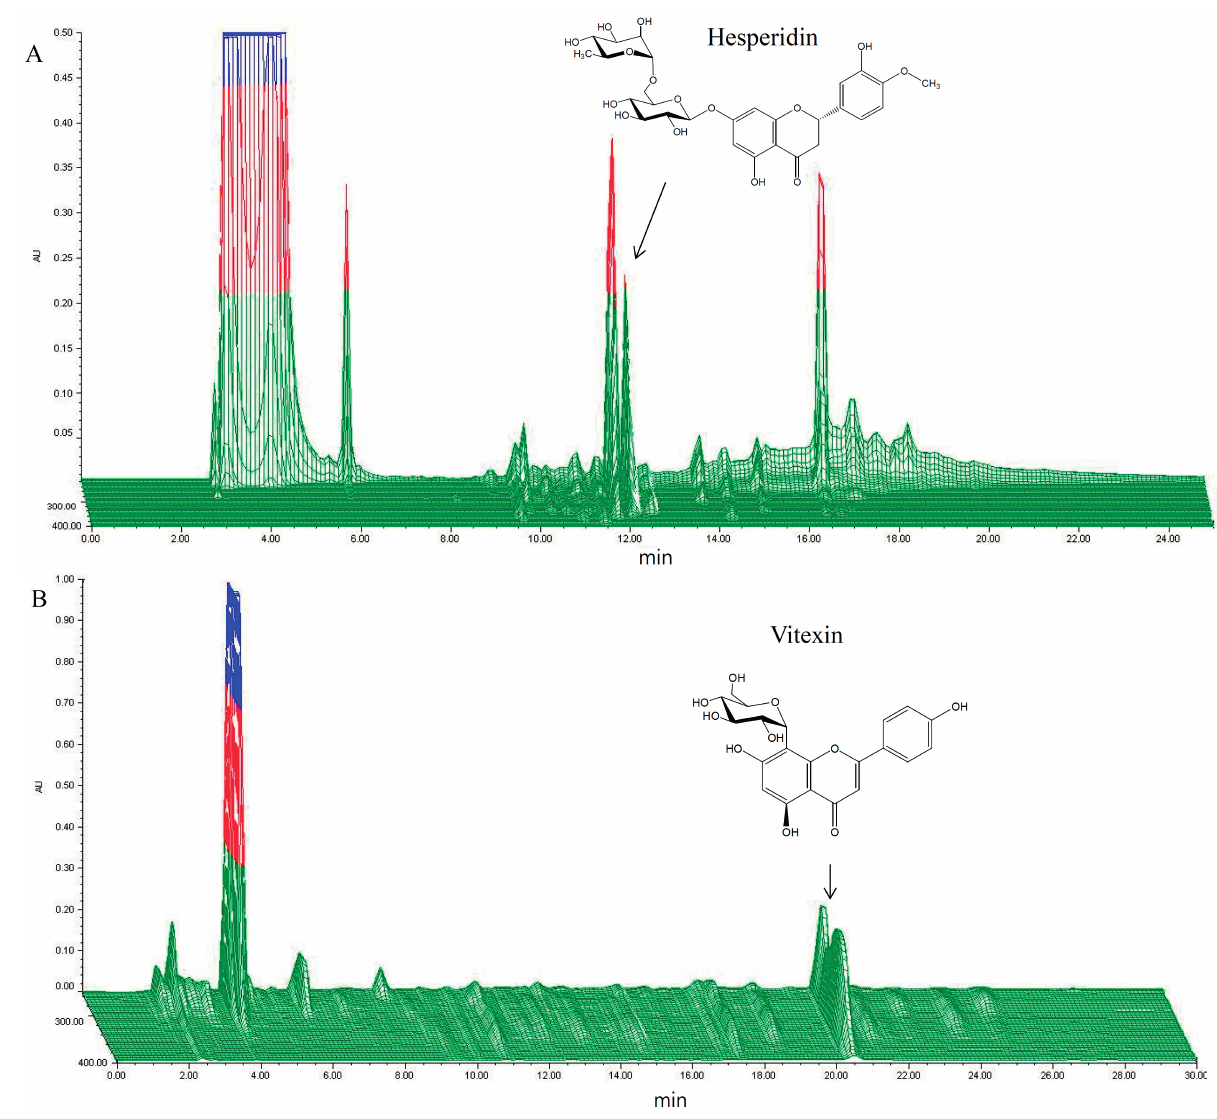
Figure 1. 3-D HPLC chromatogram of HT048, a blend of two herbal extracts ( A ) C. unshiu peel of hesperidin; ( B ) C. pinnatifida leaf of